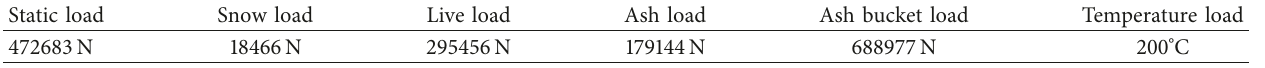
Table 8: The load information of the bottom beam and bracket.